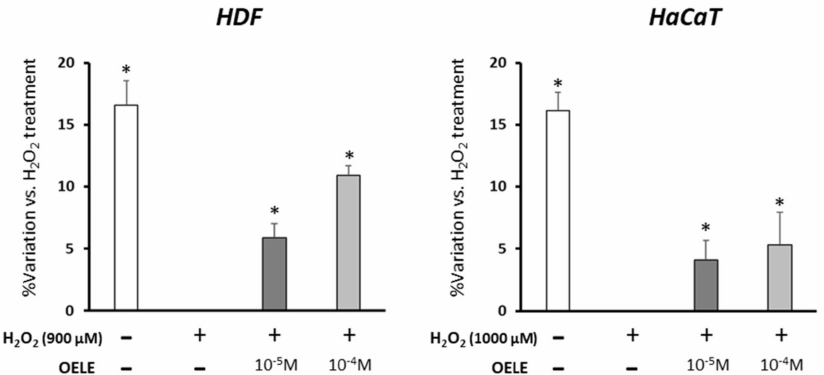
Figure 4. Effect of OELE on cell viability in human dermal fibroblasts (HDFs) and epidermal keratinocytes (HaCaT) cultures exposed to oxidative stress induced by H 2 O 2 . * p < 0.05 vs. control + H 2 O 2 .